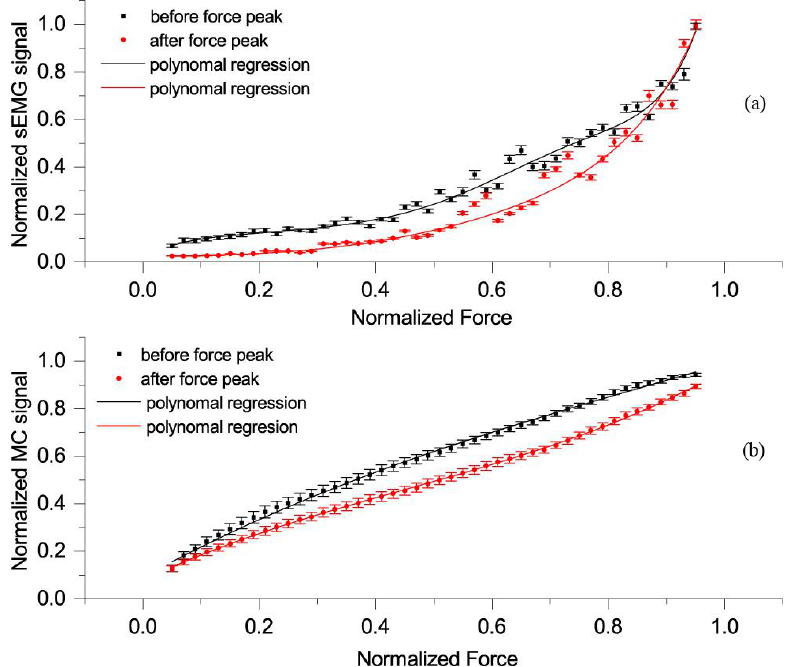
Figure 7. ( a ) Each point on curves is the average of all records of the mean normalized sEMG, obtained when F was within 2% of each chosen force value (0.02, 0.4...to 0.98 at D elbow angle 90°) while the force was rising ( i.e ., before the peak, black colour) or while force was falling ( i.e ., after the peak, red colour). Bars show SEM, and line is polynomial regression of the relationship between F and F , before the peak (adjusted R 2 = 0.96) MC D and red line after the peak (adjusted R 2 = 0.96); ( b ) Each point on curves is the average of all records of the mean normalized F , obtained when F was within 2% of each chosen MC D force value (0.02, 0.4...to 0.98 at elbow angle 90°) while the force was rising ( i.e ., before the peak, black colour) or while force was falling ( i.e ., after the peak, red colour). Bars show SEM, and line is polynomial regression of the relationship between F and F , MC D before the peak (adjusted R 2 = 0.99) and red line after the peak (adjusted R 2 =